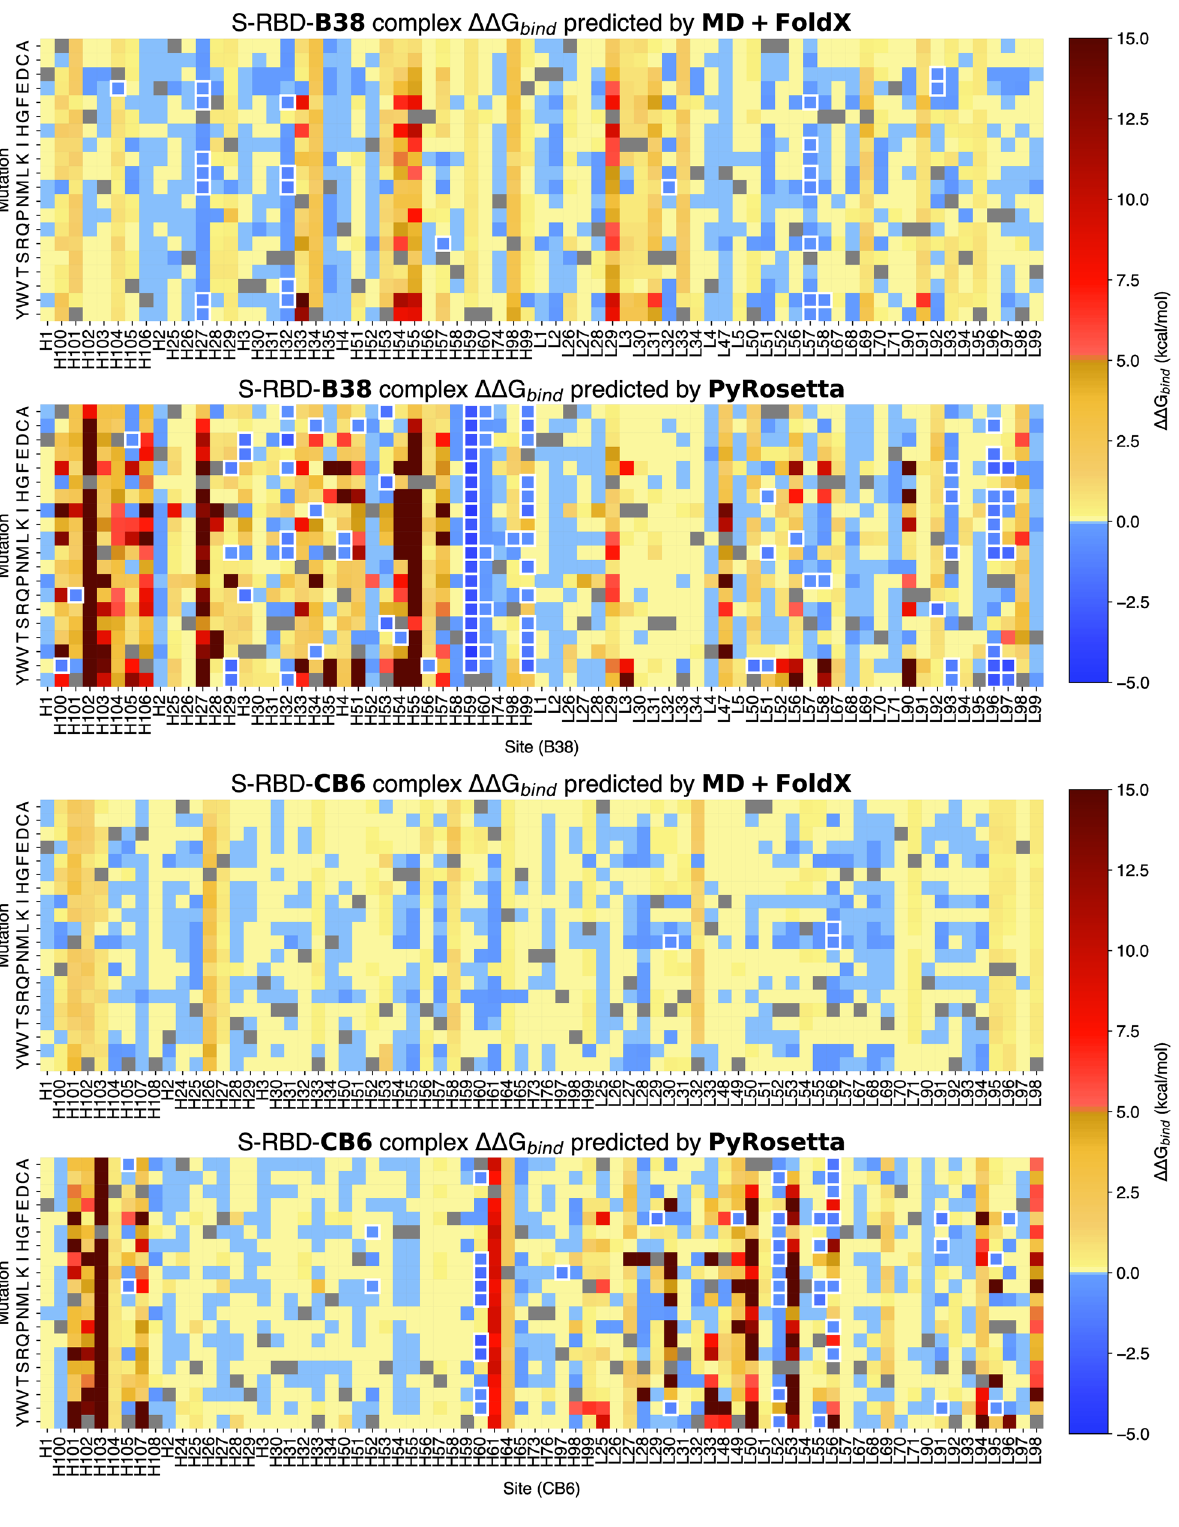
Figure 4. Heatmaps showing how mutations of B38 (top) and CB6 (bottom) modify binding to S-RBD. For each antibody, both MD + FoldX predictions (top) and PyRosetta predictions (bottom) are shown. Blue indicates stronger binding (ΔΔG bind < 0), yellow and red indicates binding disruption (ΔΔG bind > 0). Mutations predicted to be antibody strengthening (ΔΔG bind < − 0.5 kcal/mol) are highlighted in white. This figure was generated using the Python programming language v3.10.8 (Python software foundation, https:// python. org) and the matplotlib plotting module v3.5.2 40